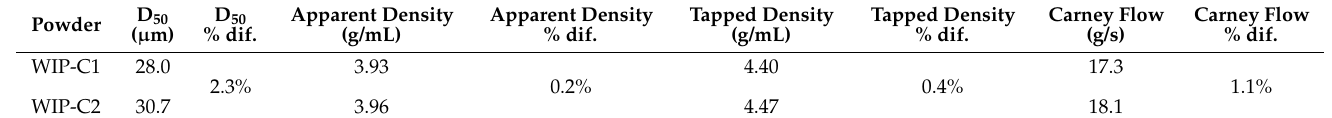
Table 7. Comparison of WIP-C1 and WIP-C2 powder properties.